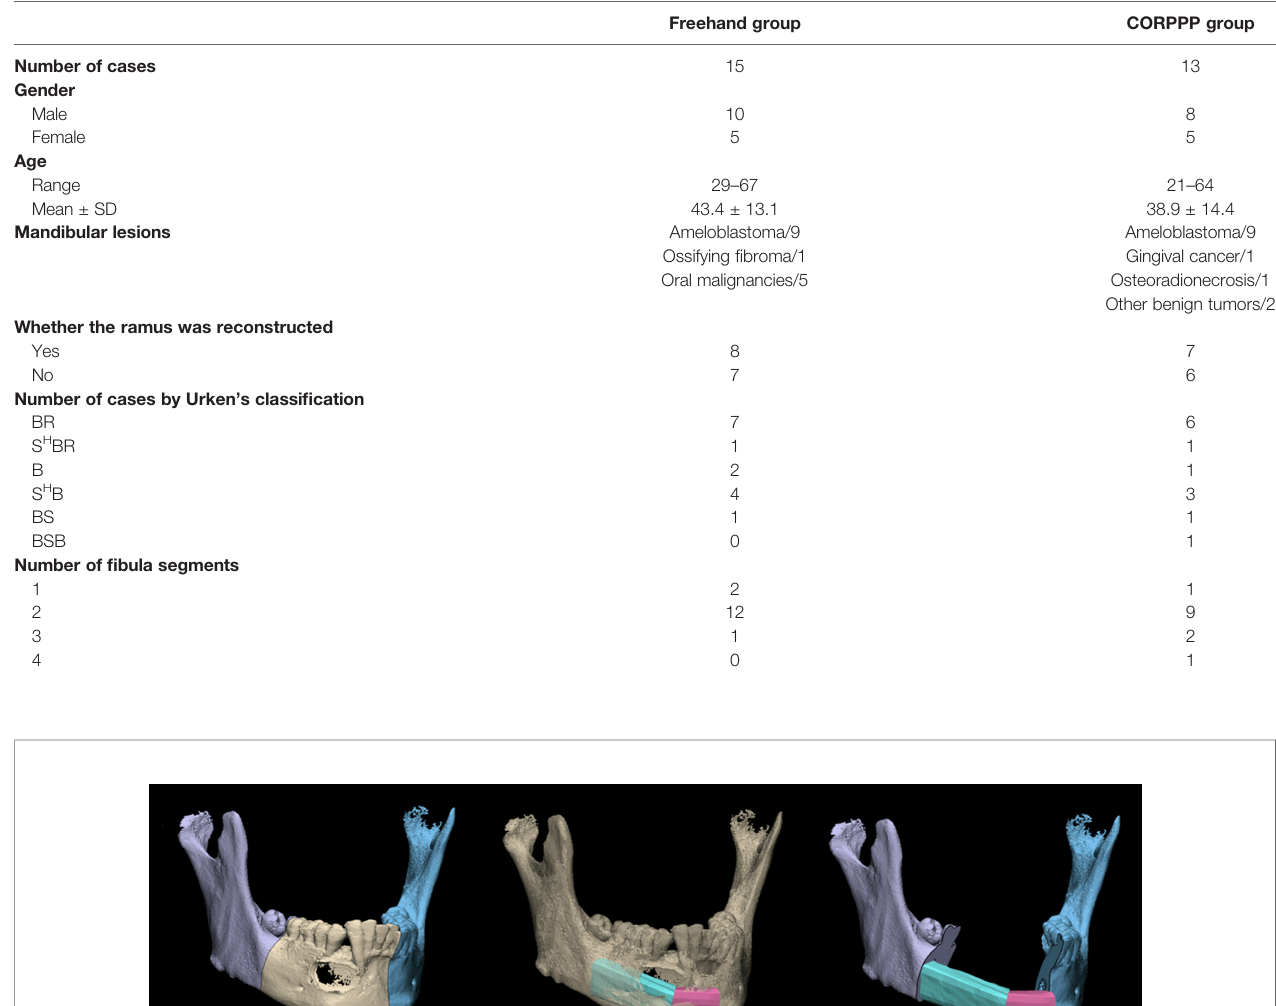
TABLE 1 | Clinical characteristics of the